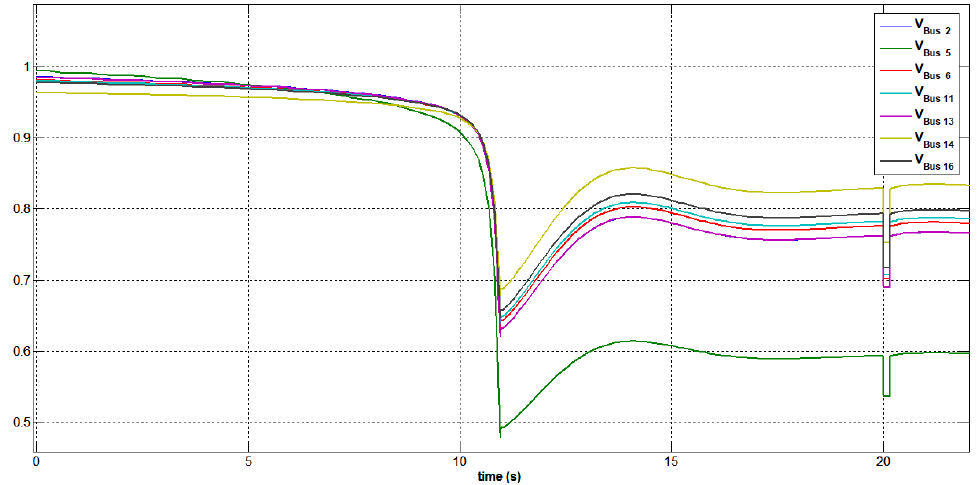
Figure 35. Voltage variation at buses 2, 5, 6, 11, 13, 14, and 16 under three-phase short circuit bus 15.